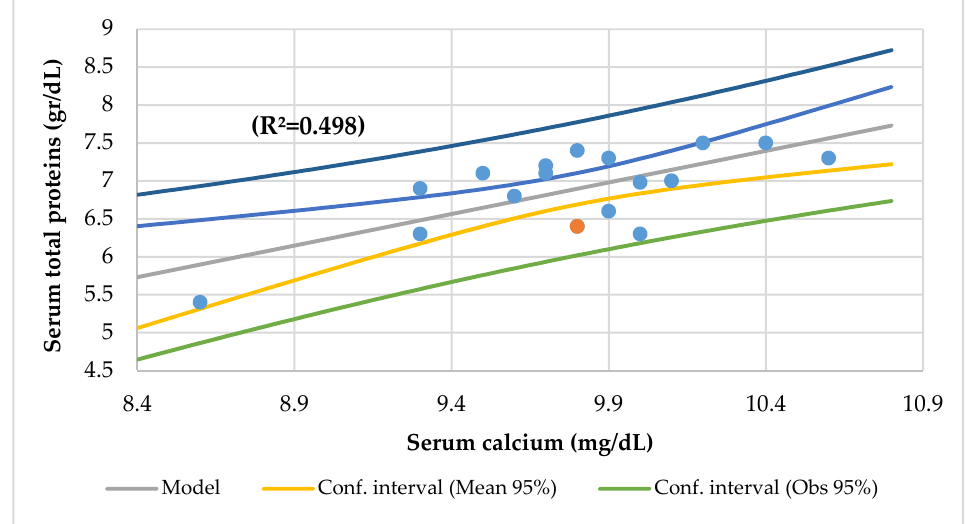
Figure 5. Regression serum total proteins (g/dL) by serum calcium (mg/dL).